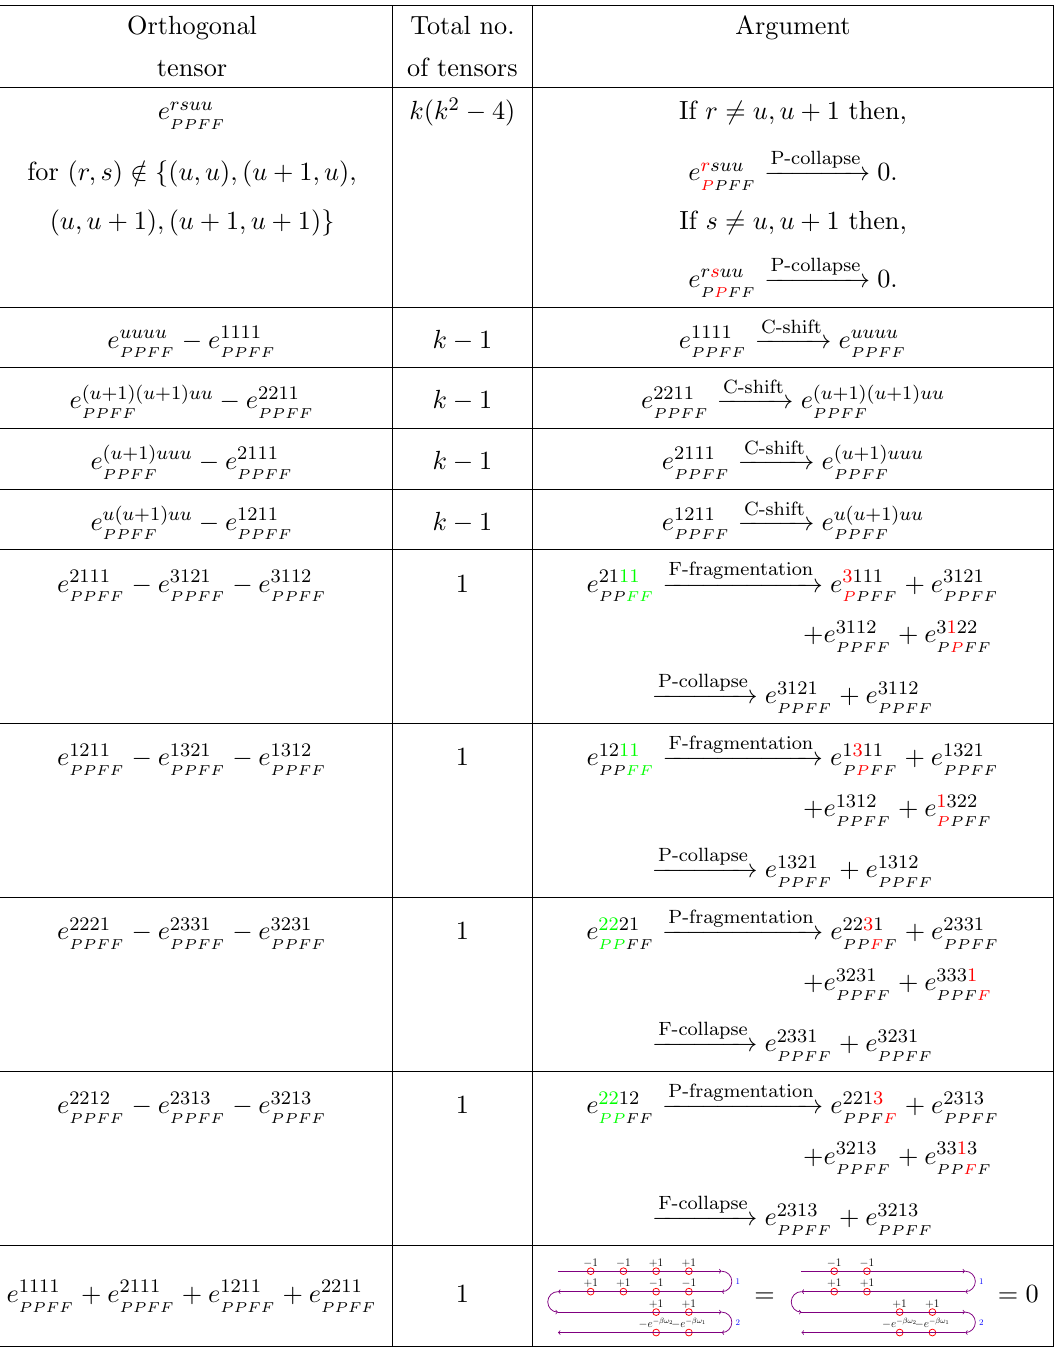
Table 12 . Arguments for the tensors in the PPFF sector orthogonal to the array of 4 point contour